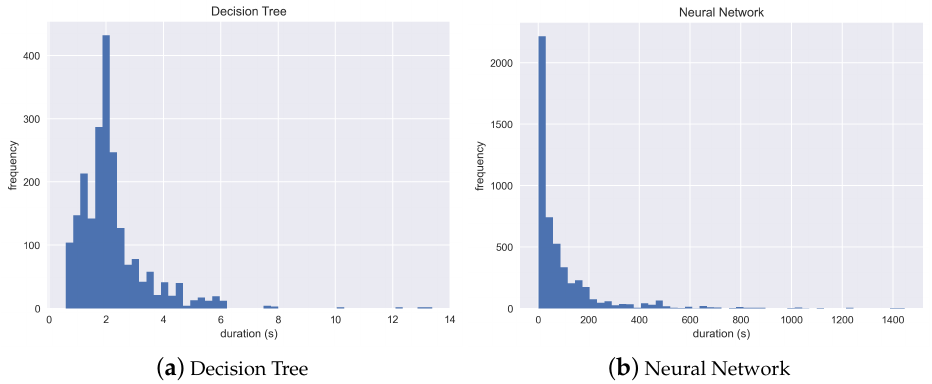
Figure 2. Histograms showing the distribution of the training time for both algorithms: Decision Tree and Neural Network.